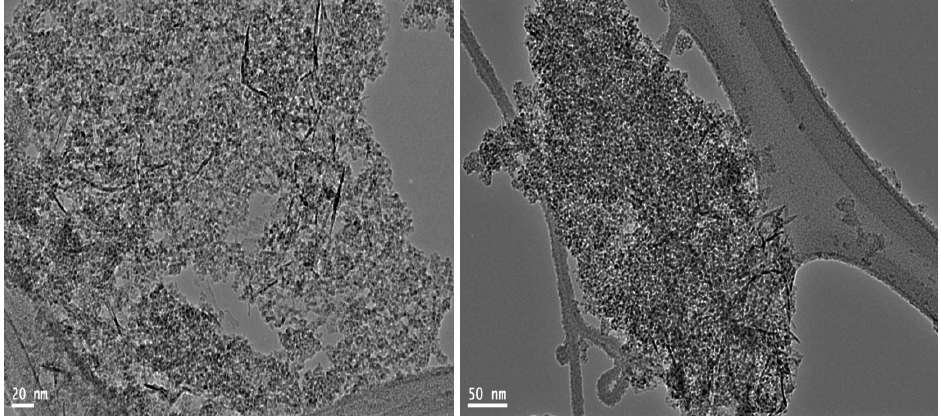
Figure 6. TEM images of the prepared nanocomposite NC-2 after thermal treatment.